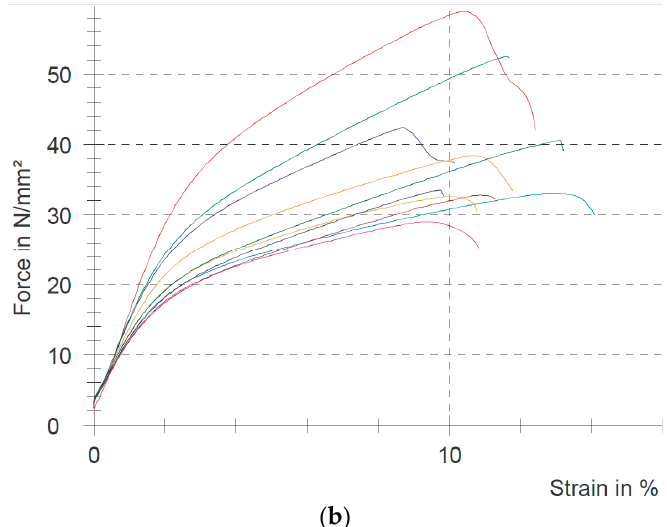
Figure 2. ( a ) Tensile stress mean values for unirradiated (0 kGy) samples (control batches) from head to tail area (A, B, C and D); ( b ) an example of the stress–strain curves for the A batch samples.